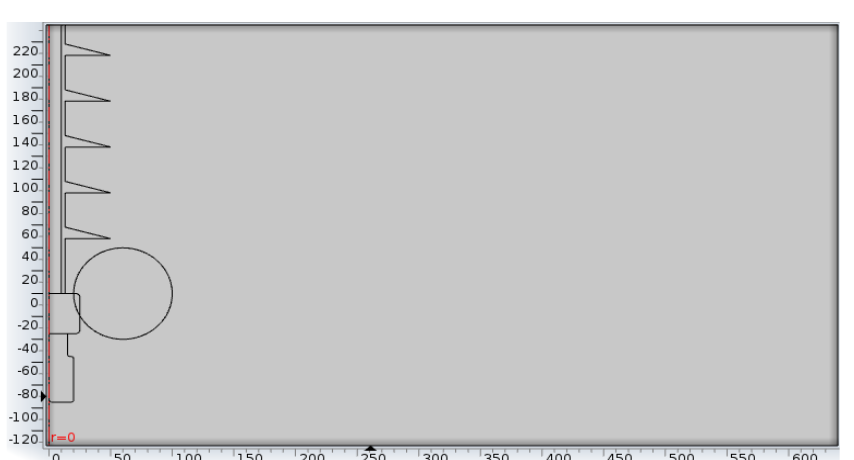
Figure 9. Overlapping corona ring along insulator string.